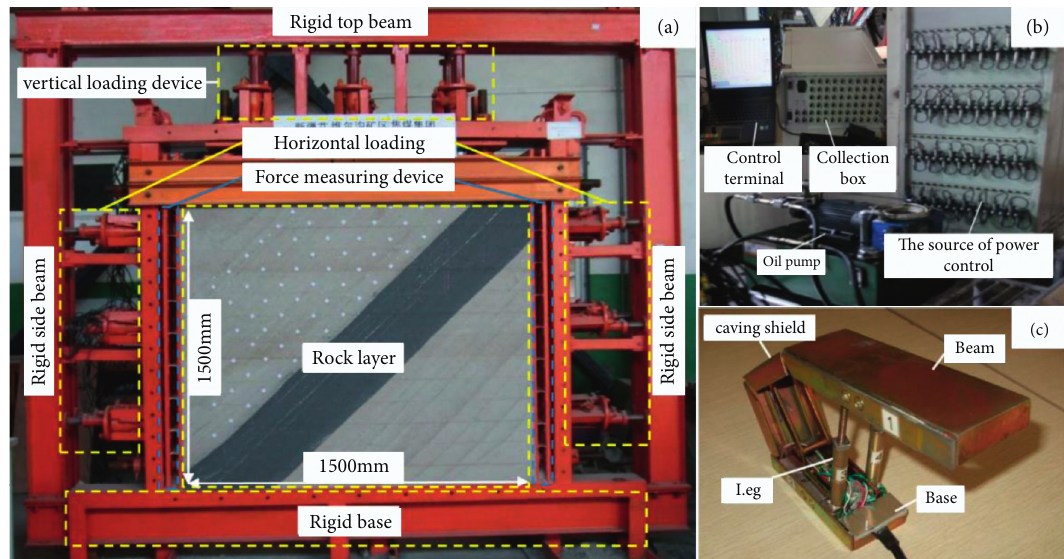
Figure 2: Test model. (a) Model. (b) Date collection system. (c) Support mode.